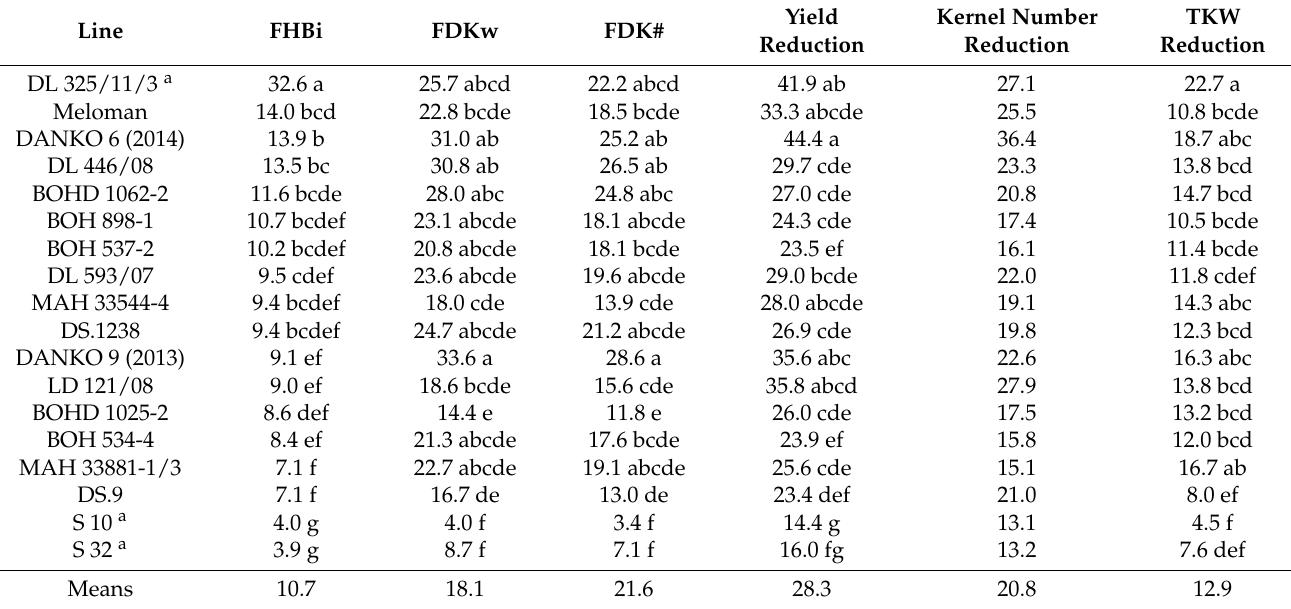
Table 2. Fusarium head blight index (%), Fusarium -damaged kernels (weight. number) (%) and reduction of yield, kernel number, and TKW (%) for 15 winter triticale and three winter wheat